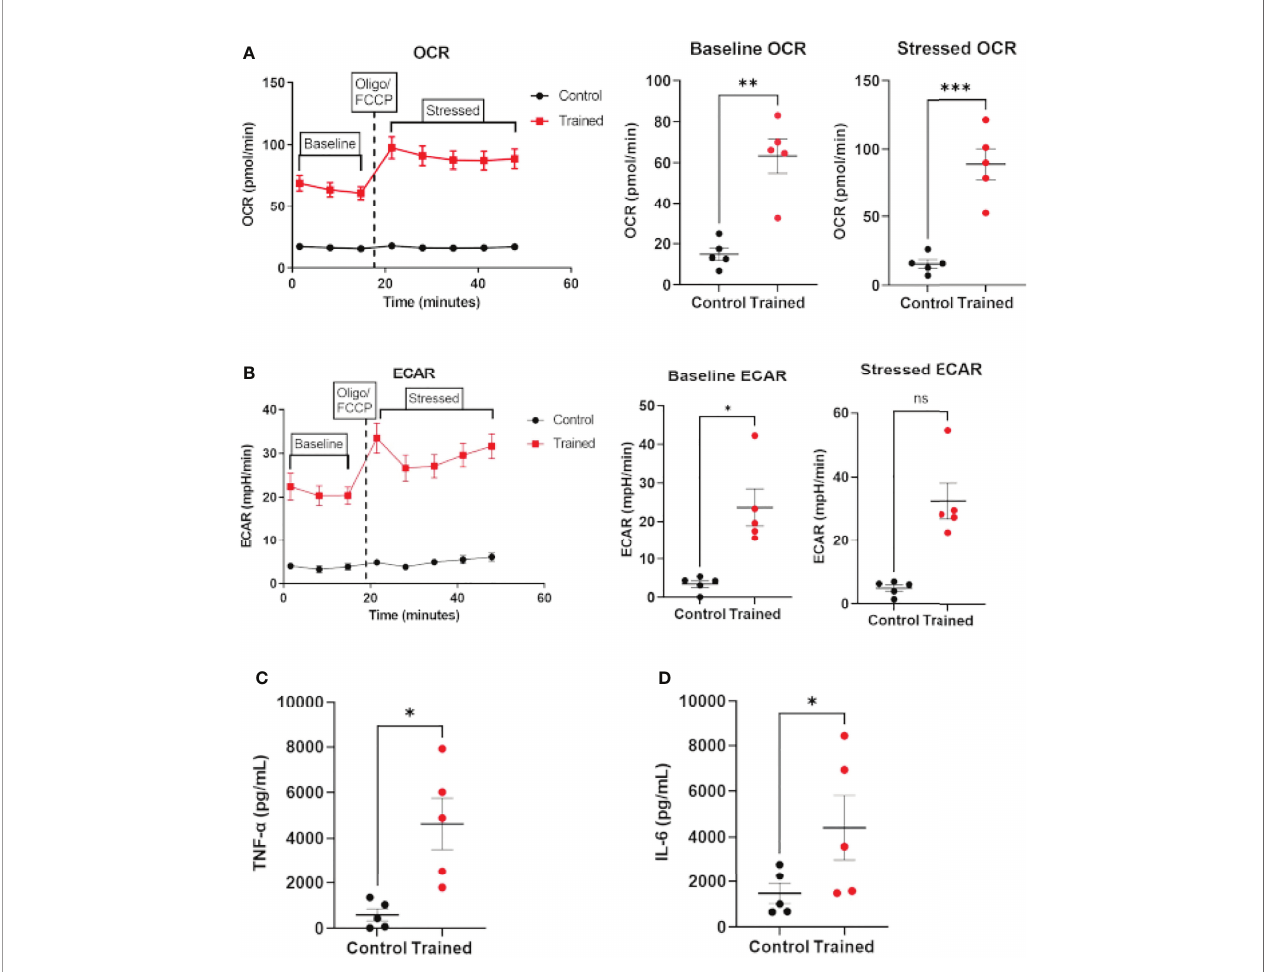
FIGURE 7 | Immune training with b – glucan induces metabolic changes and cytokine expression in monocytes from sepsis patients. (A) Baseline and stressed OCR 7 days after b – glucan or PBS treatment. (B) Baseline and stressed ECAR 7 days after b – glucan or PBS treatment. Stressed ECAR in trained septic monocytes showed an increased trend versus control monocytes, but did not achieve statistical signi fi cance (P=0.0625, N=5). (C) TNF – a expression 7 days after b – glucan or PBS treatment after 24h LPS stimulation. (D) IL – 6 expression. TNF – a and IL – 6 expression were below limit of detection levels in cells that were not treated with LPS 7 days after training or control treatment. All measures, unless otherwise speci fi ed, were analyzed using a paired t – test (*P ≤ 0.05, **P ≤ 0.01, ***P ≤ 0.001) (N=5). ns, not signi fi